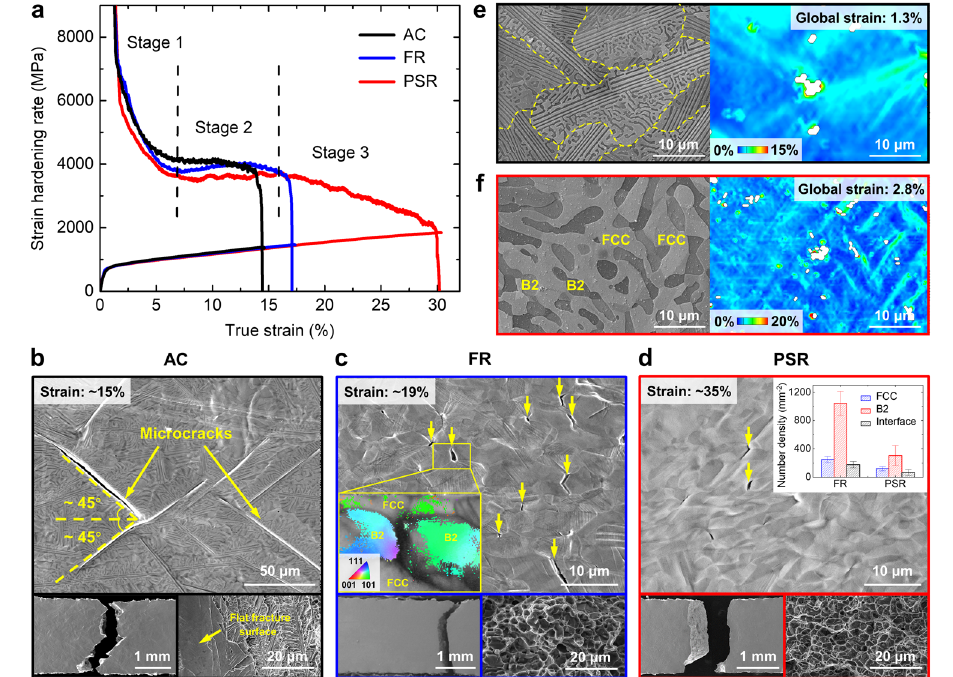
Fig. 2 | Fracture mechanisms of the PSR EHEA. a Strain hardening rate curves of theAC,FR,and PSREHEAs. b – d Fracturecross-sectionsandsurfacesoftheAC,FR, and PSR EHEAs. The microcracks within the B2 phase are marked by the yellow arrows. The inset in c shows the EBSD IPF map of the B2 phase around a typical microcrack, revealing the crack initiation at the GB. The inset in d compares the